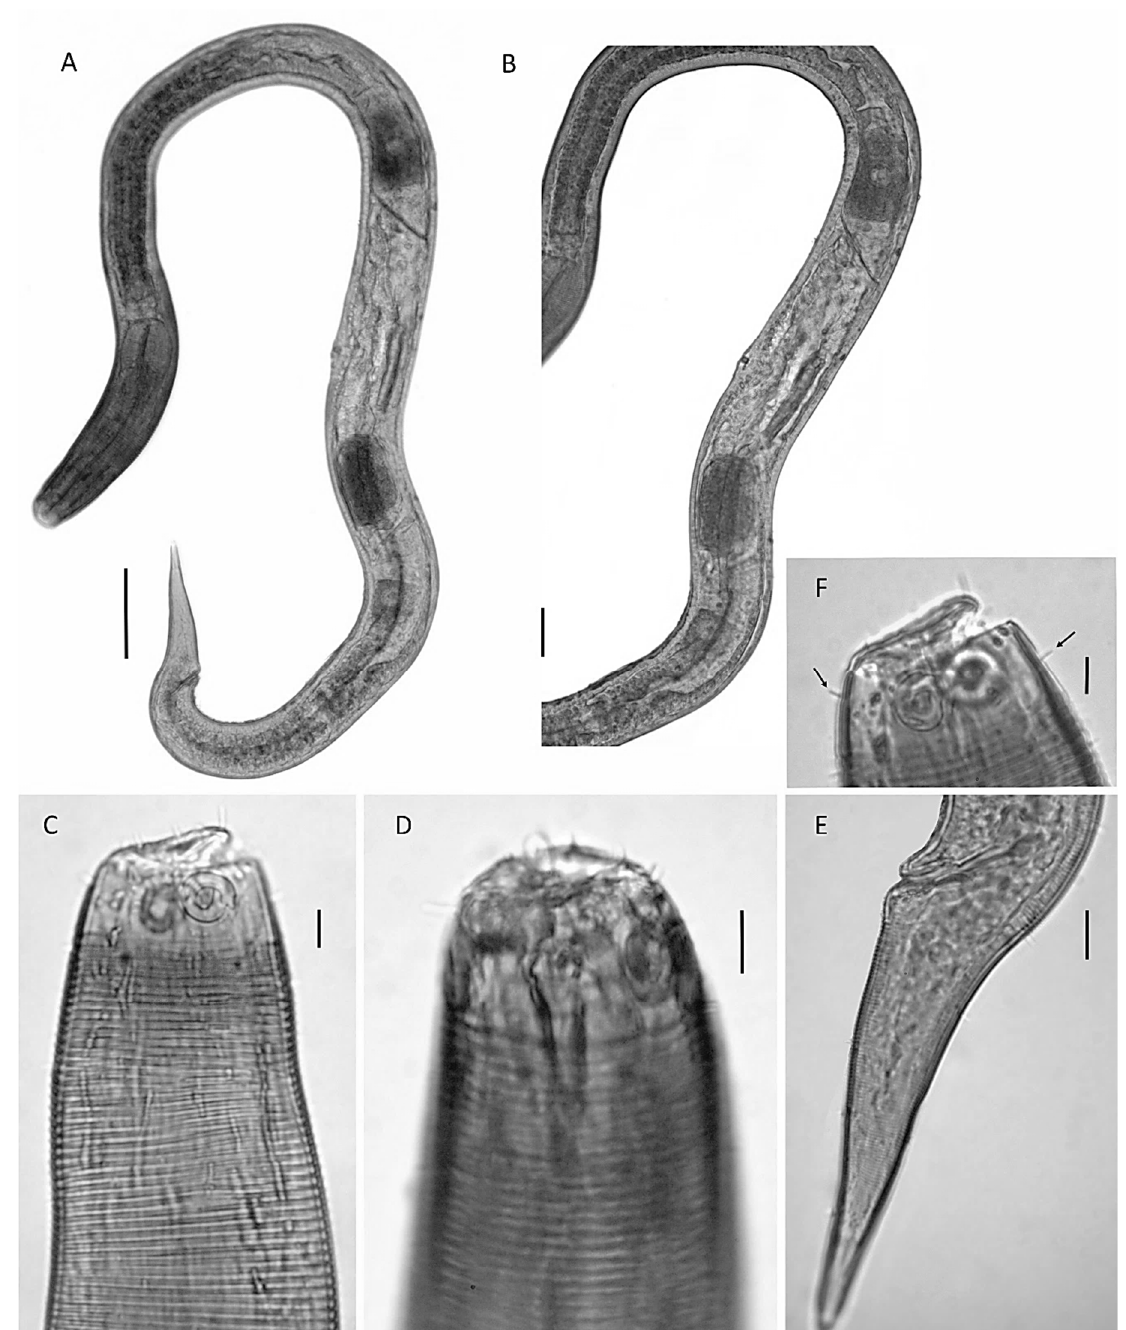
Figure 3. Pseudochromadora gomoi sp.n .—allotype female. (A) the entire female aspect; (B) detail on the reproductive system; (C) the anterior body region with ducts in the head and the isthmus part of the pharynx; (D) detail of the big dorsal tooth and the two minute ventrosublateral teeth; (E) the tail with the cloacal opening; (F) the lip region cut off revealing the slim sutura and subcephalic setae on the head capsule region (arrows); ( A , B )—scale 50 μ m; and ( C – F )—scale 10 μ m.